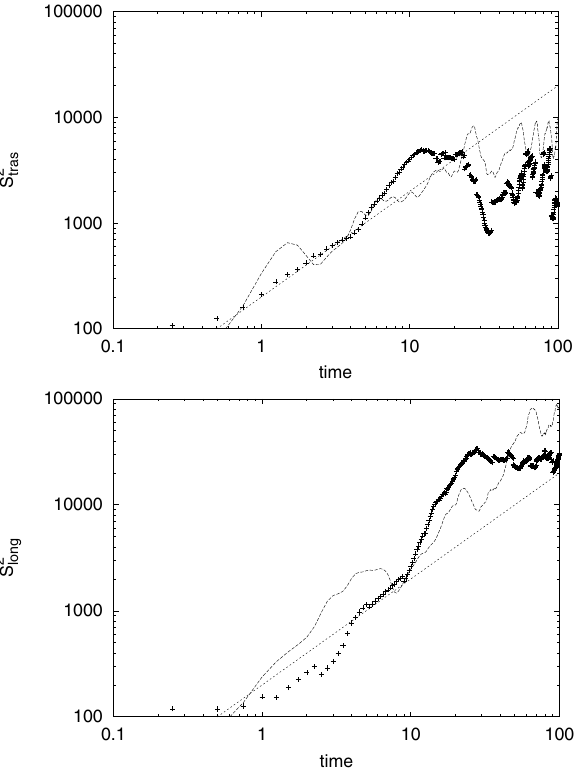
Fig. 3. Relative dispersion curves for data (plus symbol) and model (dashed) trajectories along the two natural directions in the basin geometry: (a) transverse component, (b) longitudinal component. The time is measured in days and the dispersion in km 2 . The exper- imental curve is computed over the 37 drifter trajectories; the model curve is computed over a cluster of 10 4 particles, initially placed at the border of the southern gyre with a mean square displacement of ∼ 50 km 2 . The straight line with slope 1 has been plotted for comparison with a standard diffusive scaling with a corresponding diffusion coefficient ∼ 10 3 m 2 /s, typical of marine turbulent mo-